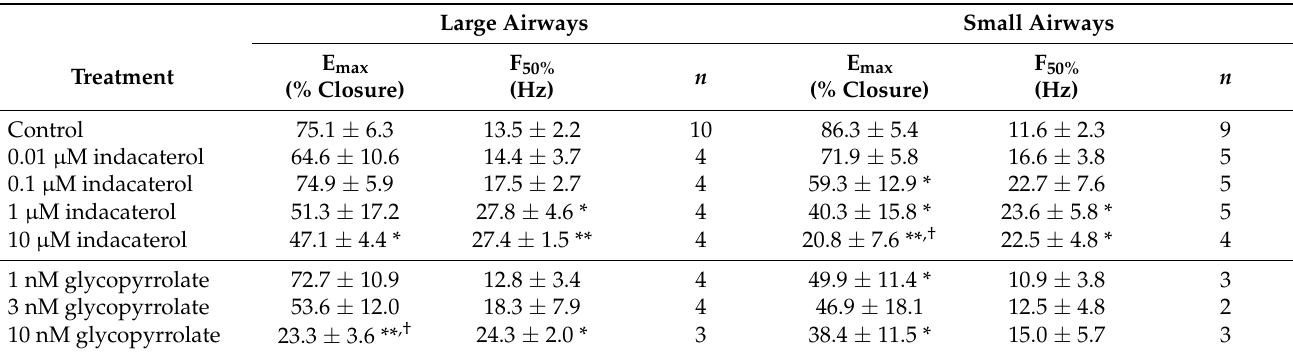
Table 2. Effects of indacaterol and glycopyrrolate on EFS-induced airway constriction of large and small airways in guinea pig lung